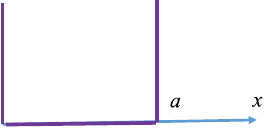
FIG. 2. An example of the exam problem about the time evolution of the wave